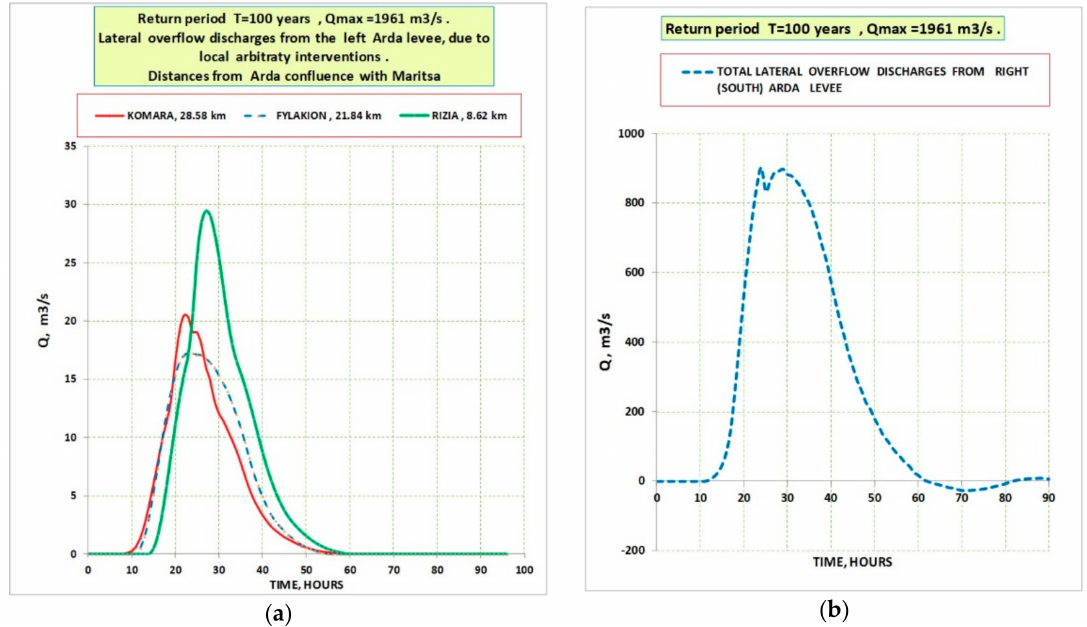
Figure 8. ( a ) Side overflows from the left (north) levee at three places; ( b ) Total side overflow from the right (south) levee of the Arda